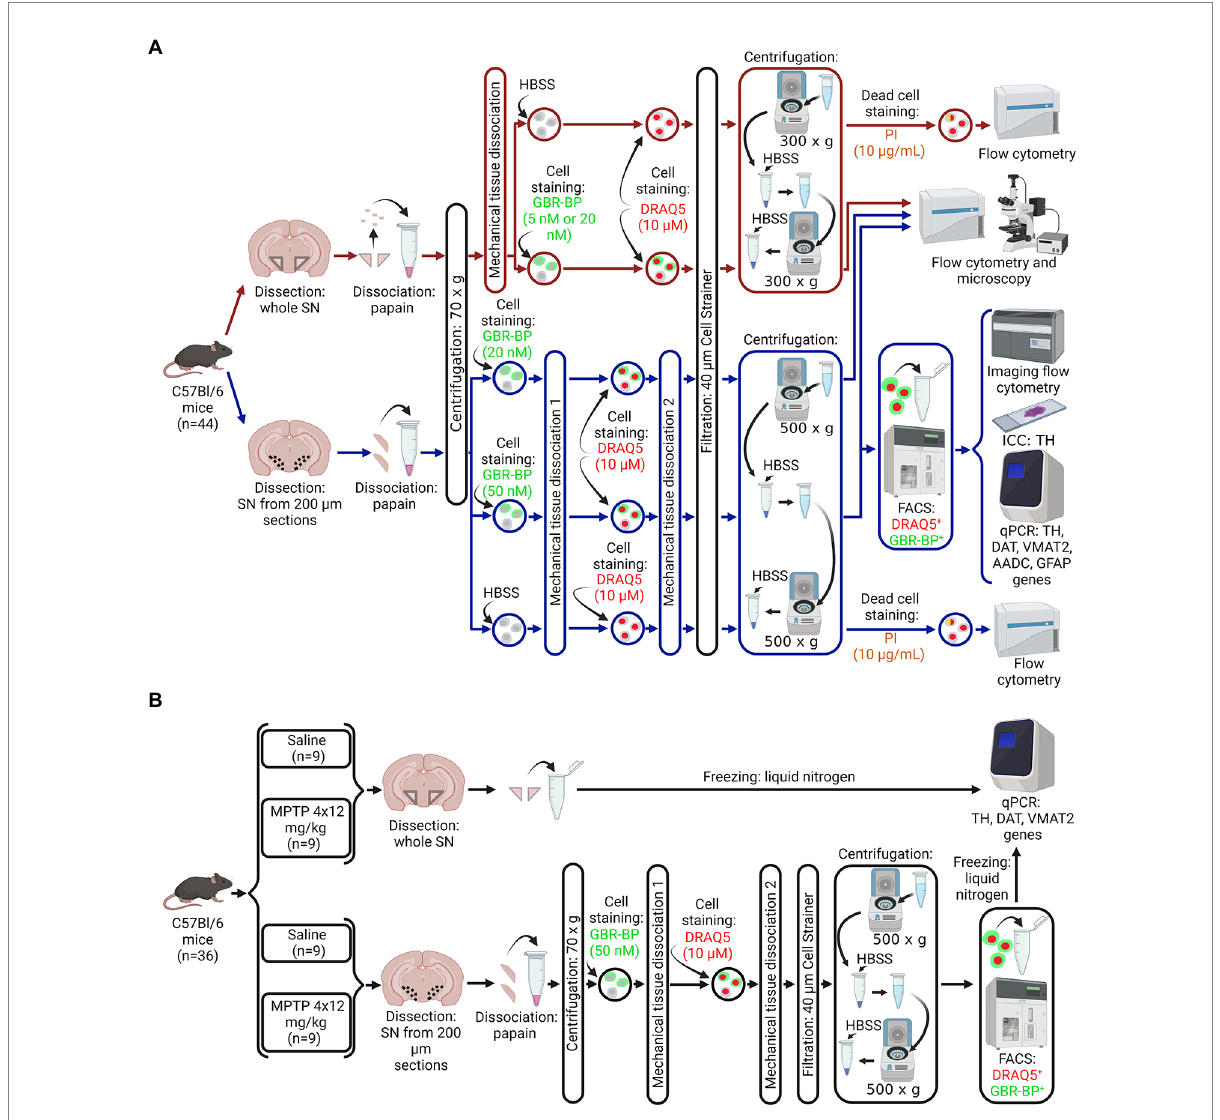
FIGURE 1 Design of experiments. (A) Protocol for isolating a population of dopaminergic neurons (DNs) from a cell suspension of the whole substantia nigra (SN) or vibratome sections of the SN obtained from intact mice for subsequent assay by flow cytometry, immunocytochemistry, and quantitative polymerase chain reaction (qPCR). (B) Sample preparation for the analysis of gene expression of DN marker proteins in a homogenate of a whole SN or in a population of DNs isolated from a cell suspension of SN vibratome sections obtained from mice in a model of the early clinical stage of Parkinson’s disease using 1-methyl-4-phenyl-1,2,3,6-tetrahydropyridine (MPTP) and control (saline). Created with BioRender.com. AADC, aromatic L-amino acid decarboxylase; DAT, dopamine transporter; DRAQ5, a nuclear dye, FACS, fluorescence-activated cell sorting; GBR-BP, a specific DN dye; GFAP, glial fibrillary acid protein; HBSS, Hank’s balanced salt solution; PI, propidium iodide; TH, tyrosine hydroxylase; VMAT2, vesicular monoamine transporter